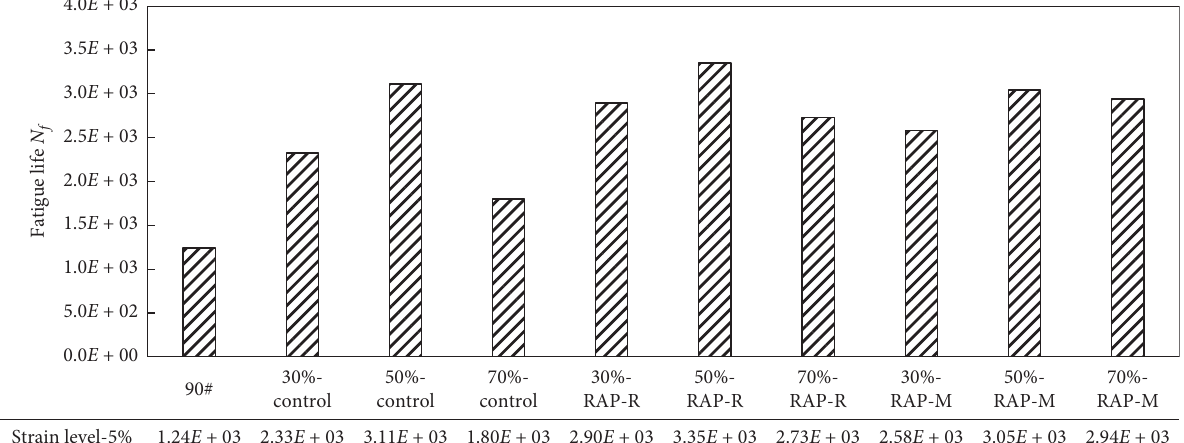
Figure 30: N f at applied strain level of 5% for various asphalt binders.